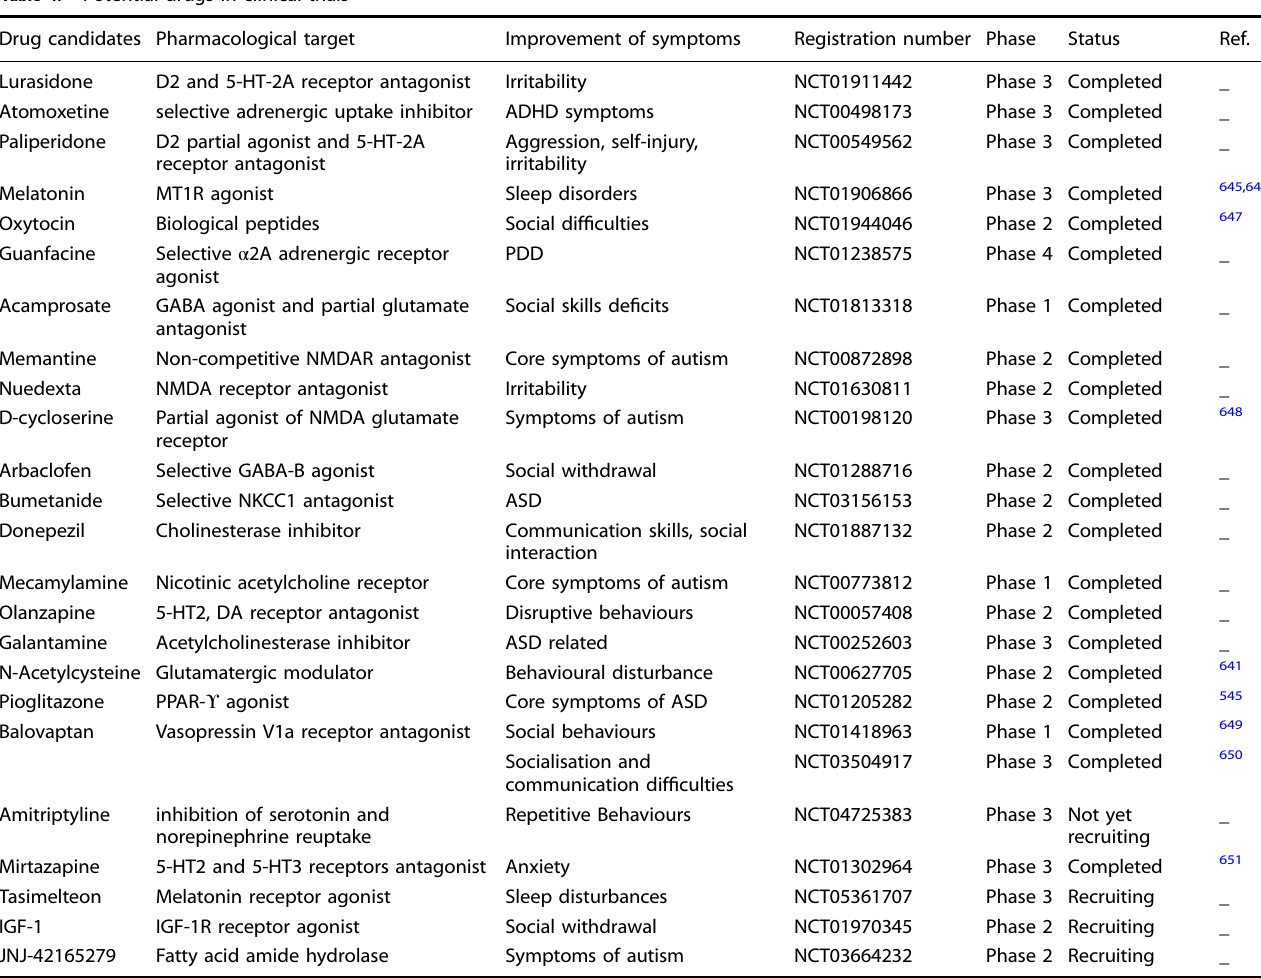
Table 4. Potential drugs in clinical trials Drug candidates Pharmacological target Improvement of